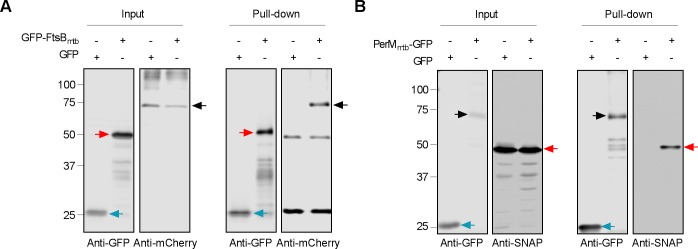
FtsBmtb and PerMmtb interact in vivo.(A) Co-immunoprecipitation of FtsBmtb and PerMmtb from whole-cell protein lysates of M. smegmatis ∆perM::perMmtb-mCherry::gfp-ftsBmtb. Lysates from M. smegmatis ∆perM::perMmtb-mCherry::gfp served as a control. GFP-containing proteins were immunoprecipitated with anti-GFP mAB-agarose beads. Whole-cell lysates (input) and eluates (pull-down) were analyzed by western blotting with anti-GFP or anti-mCherry antibodies. GFP (cyan arrows), GFP-FtsBmtb (red arrows), PerMmtb-mCherry (black arrows). (B) Reverse pull-down with PerMmtb as ‘bait’ protein from whole-cell protein lysates of M. smegmatis WT::perMmtb-gfp transformed with a plasmid expressing snap-ftsBmtb. Lysates from M. smegmatis WT::gfp transformed with a plasmid expressing snap-ftsBmtb served as a control. Following immunoprecipitation of GFP-containing proteins with anti-GFP magnetic beads, we analyzed whole-cell lysates and eluates with anti-GFP or anti-SNAP antibodies. GFP (cyan arrows), PerMmtb-GFP (black arrows), SNAP-FtsBmtb (red arrows). Data in (A and B) are representative of two independent experiments.